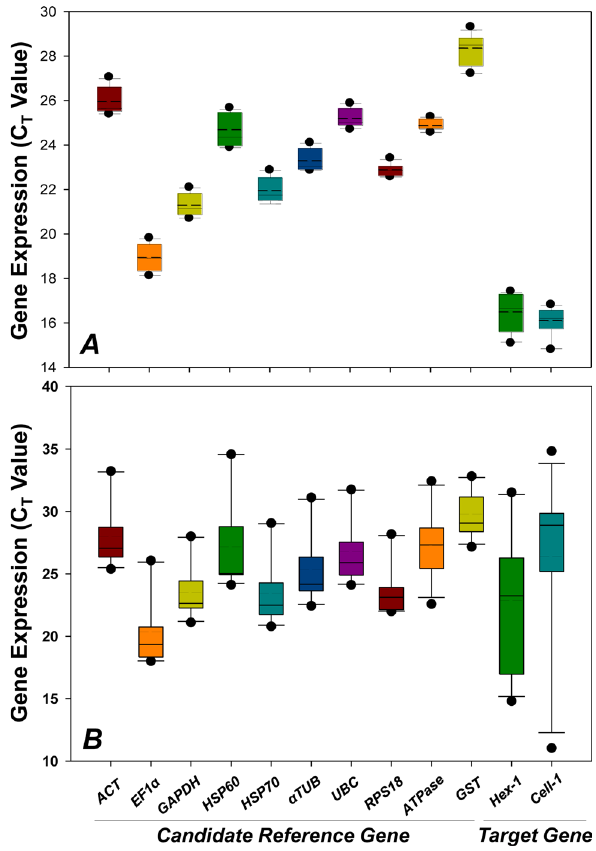
Figure 3. Variability of candidate genes at mRNA level among different experimental conditions. BoxPlots of ( A ) different developmental stages and ( B ) different tissues were generated from raw C T values of ten candidate reference genes and two target genes examined by RT-qPCR analysis. The plots denote median, upper and lower quartiles, and 10th and 90th percentile of data. Dashed lines within bars denote the